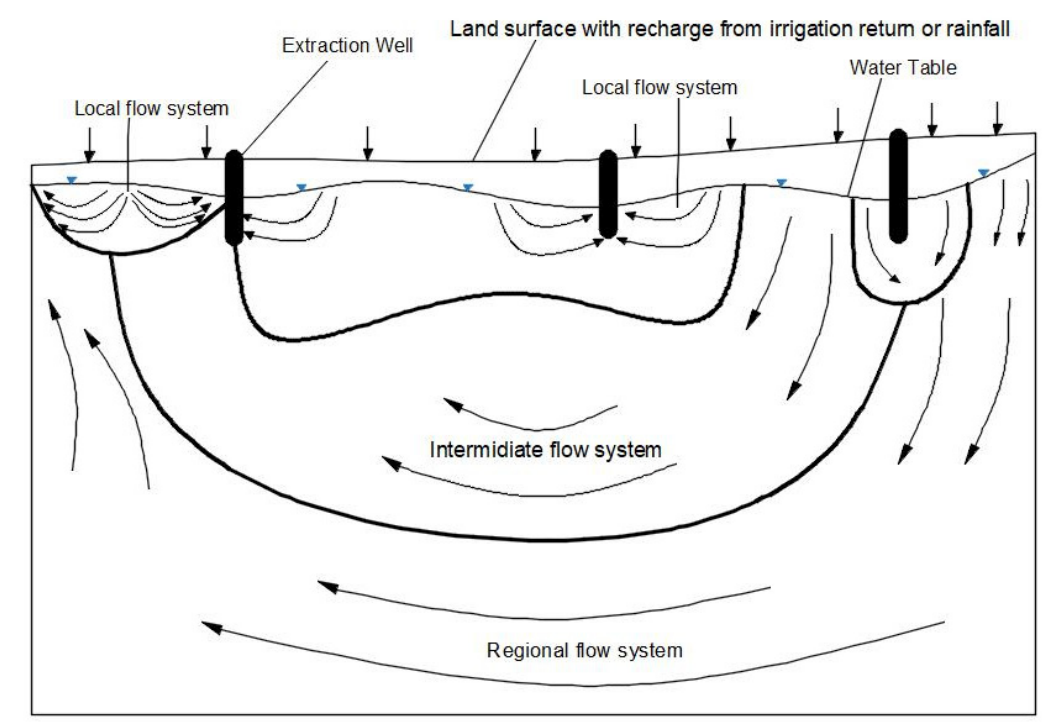
Figure 4. Groundwater fl ow systems: Local, Intermediate and Regional, as described by Tóth [48].